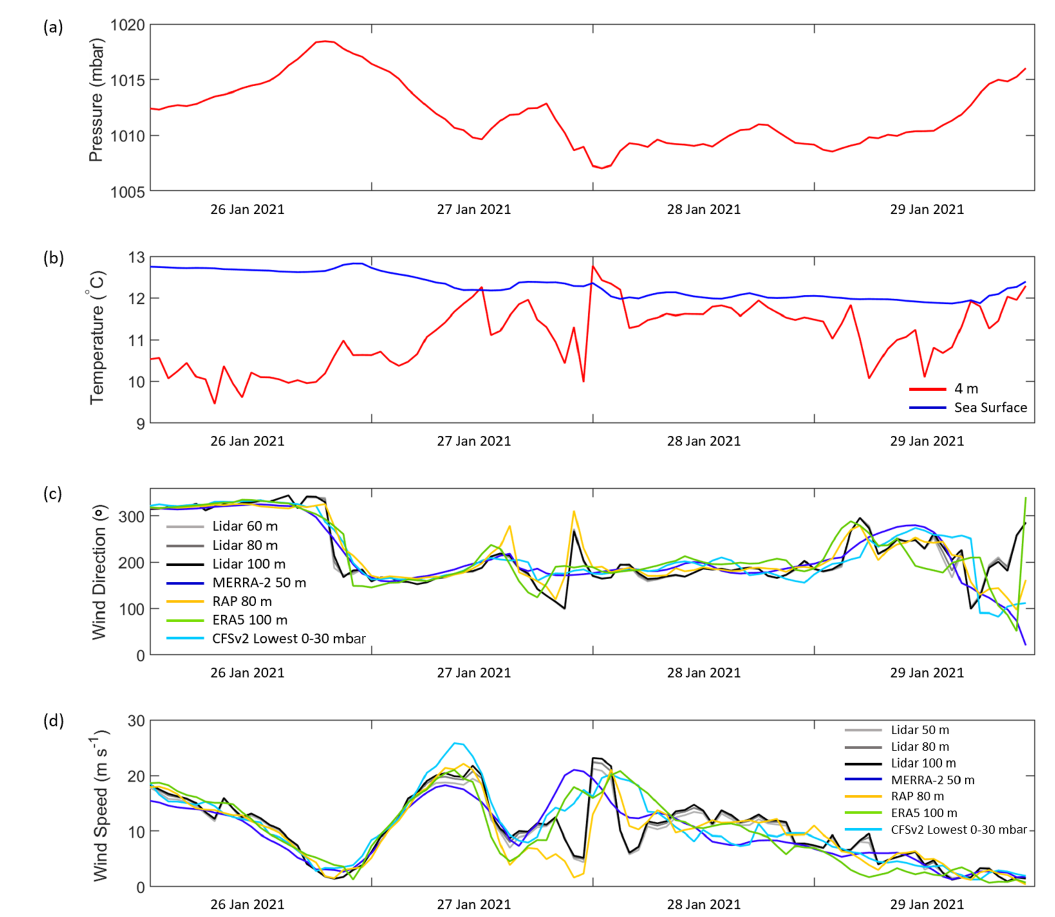
Figure 17. (a) Observed pressure, (b) observed air and sea temperature, (c) observed wind speed, and (d) observed and modeled wind speed at the Morro Bay buoy during the January 2021 western US atmospheric river